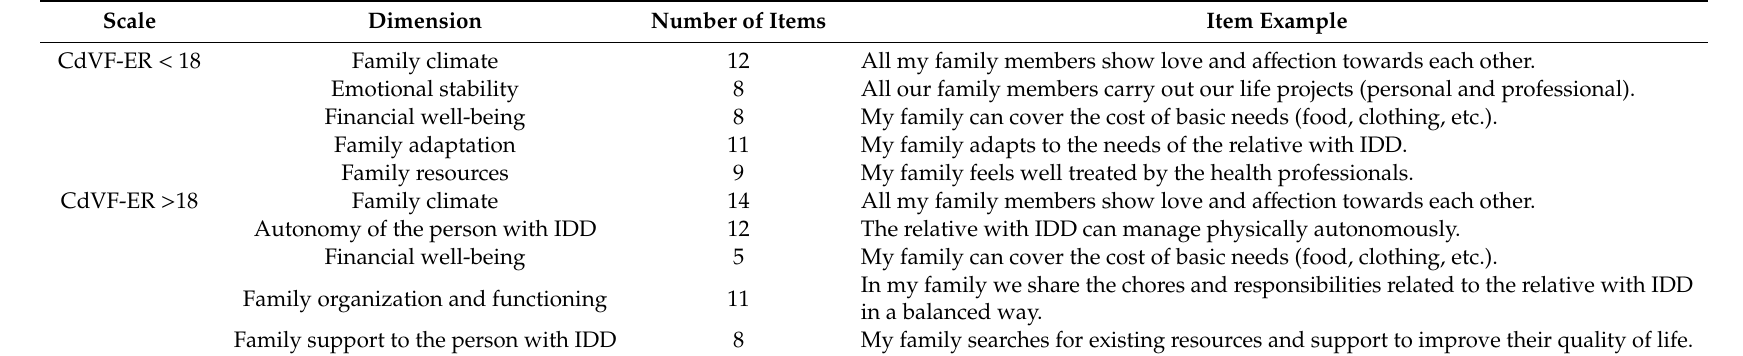
Table A2. Dimensions, number and examples of the CdVF-ER < 18 and the CdVF-ER > 18 scales’